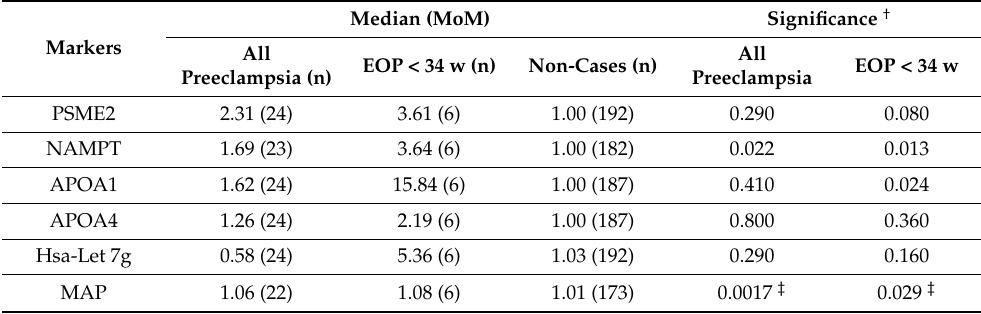
Table 6. Preeclampsia and MoMs of RNA markers, mean arterial blood pressure.